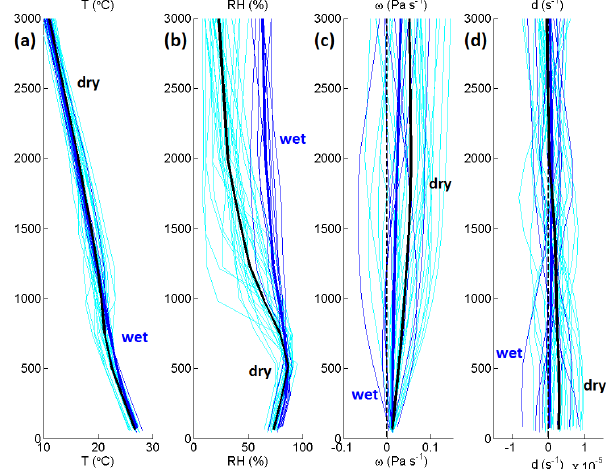
Figure A3. ECMWF temperature, relative humidity, pressure ver- tical velocity, and divergence over MCOH for wet (thin blue lines; mean: thick blue lines) vs. dry (thin cyan lines; mean: thick black lines) days during CARDEX. Panels (a, b) exhibit good agreement with the observed vertical profiles measured by the aircraft: as in the flight data, the dry days exhibit a stronger temperature inversion and subsequent drop in humidity, whereas wet cases have consistently higher humidity above the 1000–1500m inversion. Also consistent with the back trajectory analysis, there is stronger (c) subsidence and corresponding (d) divergence for the dry cases.